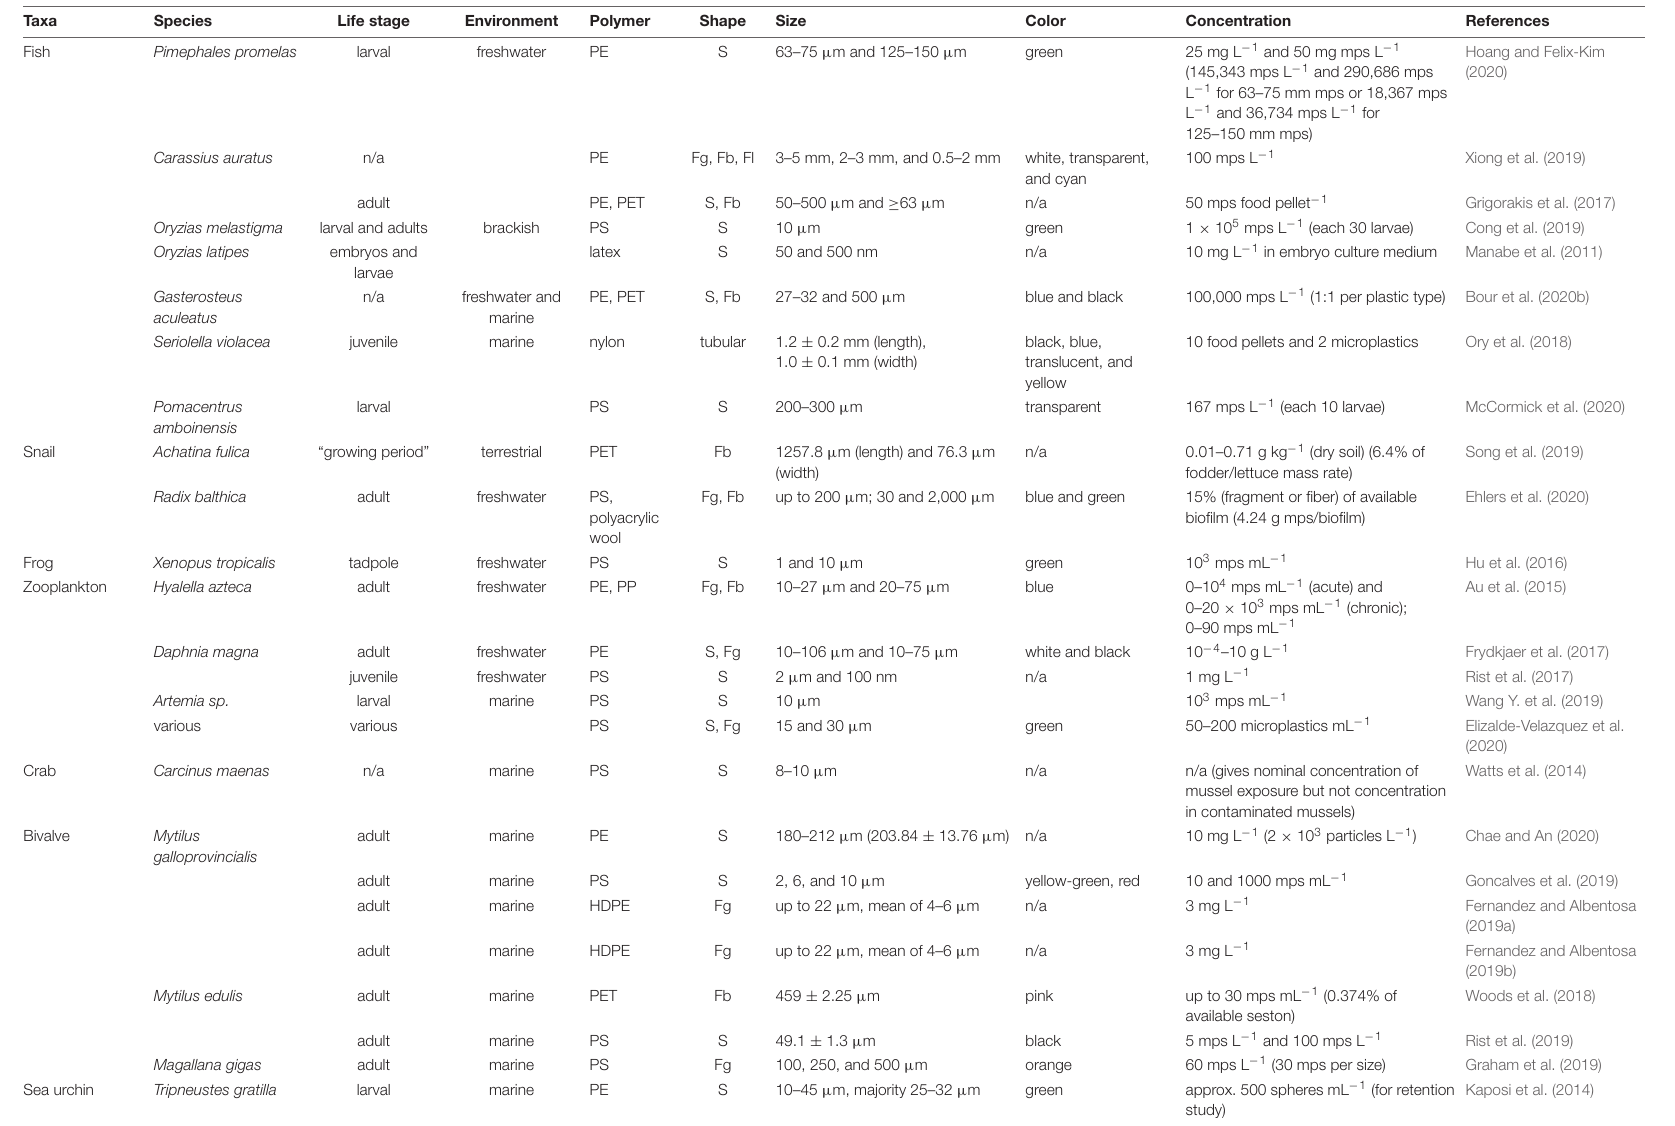
TABLE 1 | Summary of microplastic ingestion and depuration studies conducted on aquatic species.